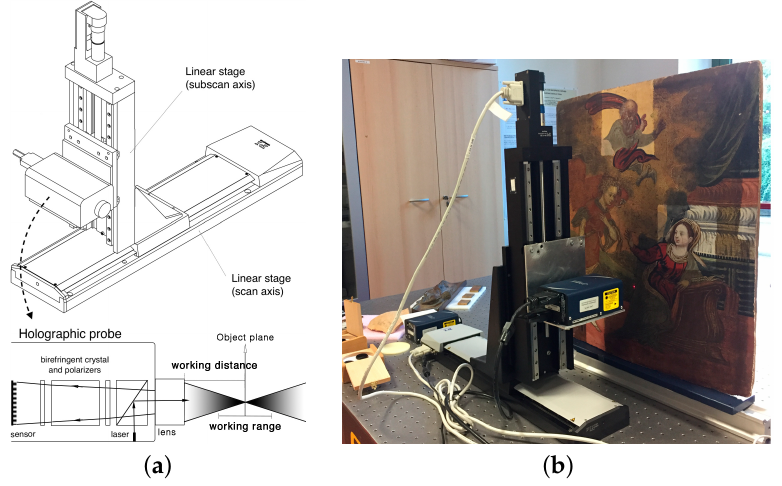
Figure 1. Microprofilometer vertical setup. ( a ) Schematic drawings with a scheme of the working principle of the probe. The orthogonal axes move the probe to scan the object plane at a safe stand-off distance; the depth measurement is effectively performed within the working range (or measurement range) of the sensor. ( b ) Application example in a real case study.